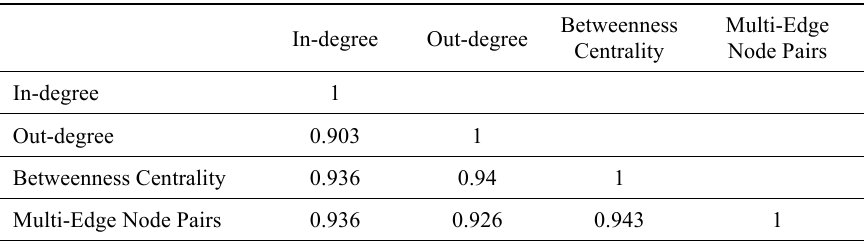
Table 1. Person Correlation Matrix. All the correlations are significant at the 0.01 level. Person Correlation